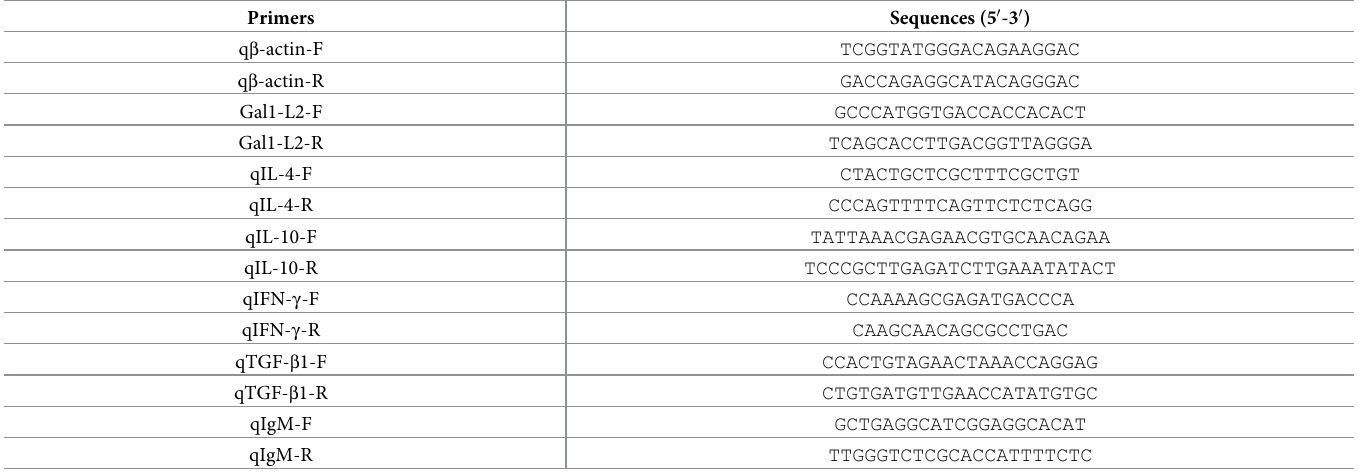
Table 1. Primers used for